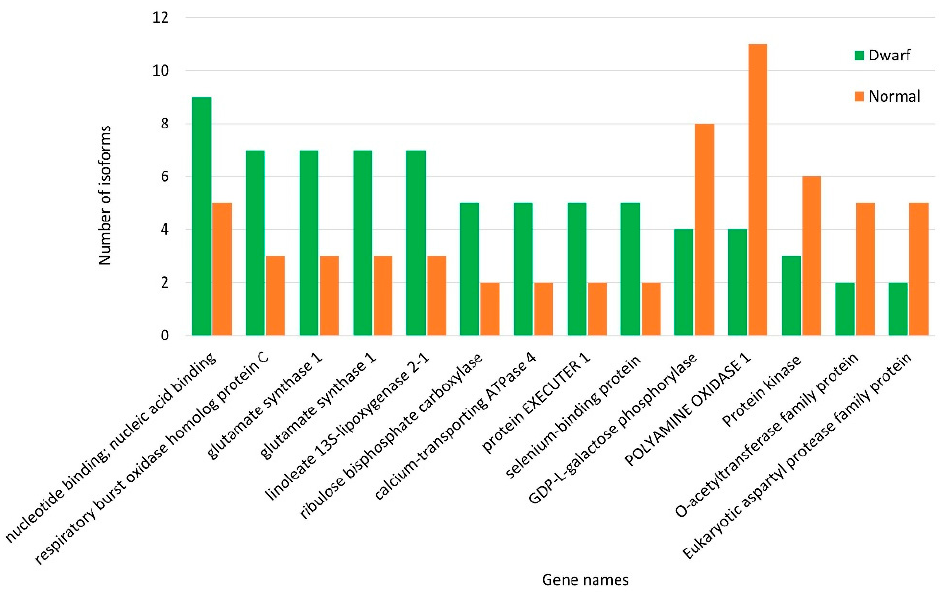
Figure 6. Number of isoforms in dwarf and normal soybean lines among genes related to the defense response. The maximum number of genes had an increased number of isoforms in dwarf as compared to normal soybean.